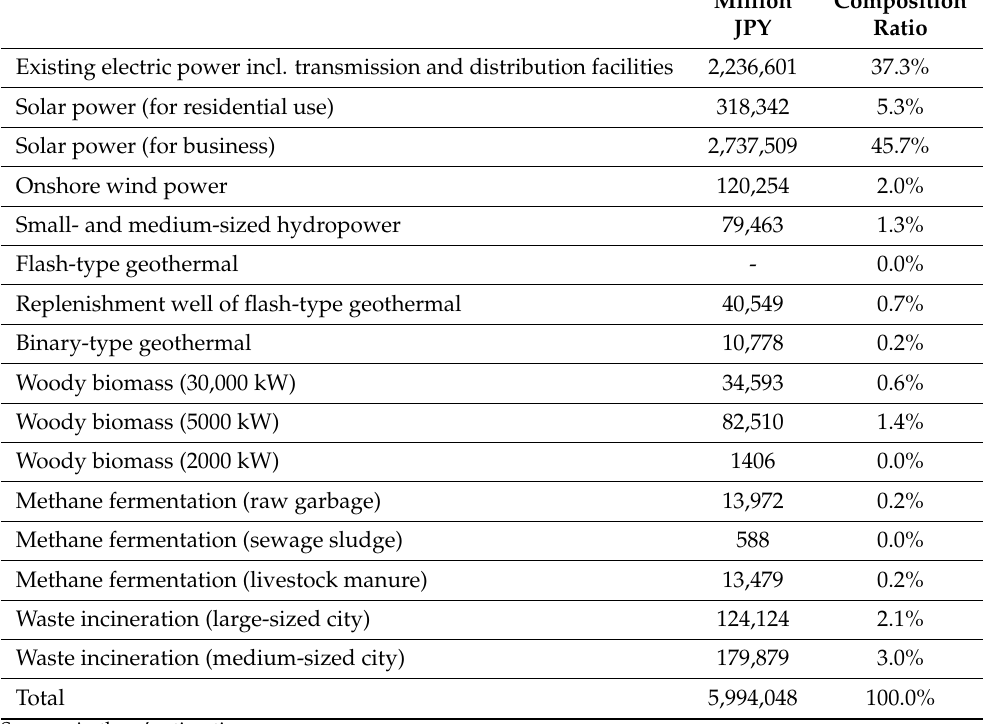
Million Composition JPY Ratio